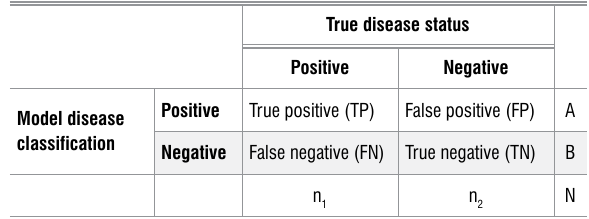
Terminology used in assessing classification accuracy